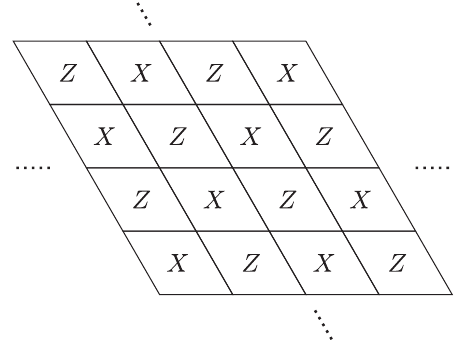
FIG. 6. Shearing the lattice of the rotated toric code. Here, X s ( Z s) represent the stabilizers, each of which is a tensor product of Pauli X s (Pauli Z s) over the qubits on the sites of the